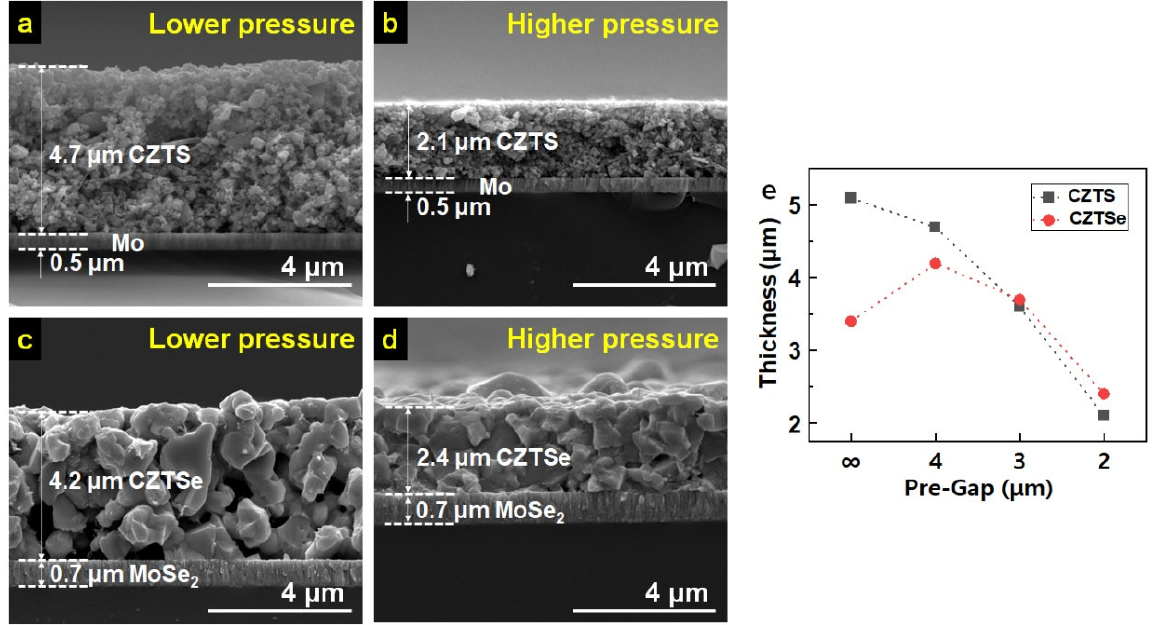
Figure 3. Cross ‐ sectional SEM images of roll ‐ pressed CZTS coats with ( a ) lower pressure and ( b ) higher pressure, respectively, on Mo/SLG. ( c , d ) Cross ‐ sectional SEM images of the selenized CZTS (CZTSe) layers of ( a ) and ( b ), respectively. ( e ) CZTS thickness before and after selenization according to pre ‐ gap of the roll press. (Black squares represent before selenization, and red circles represent after selenization.)